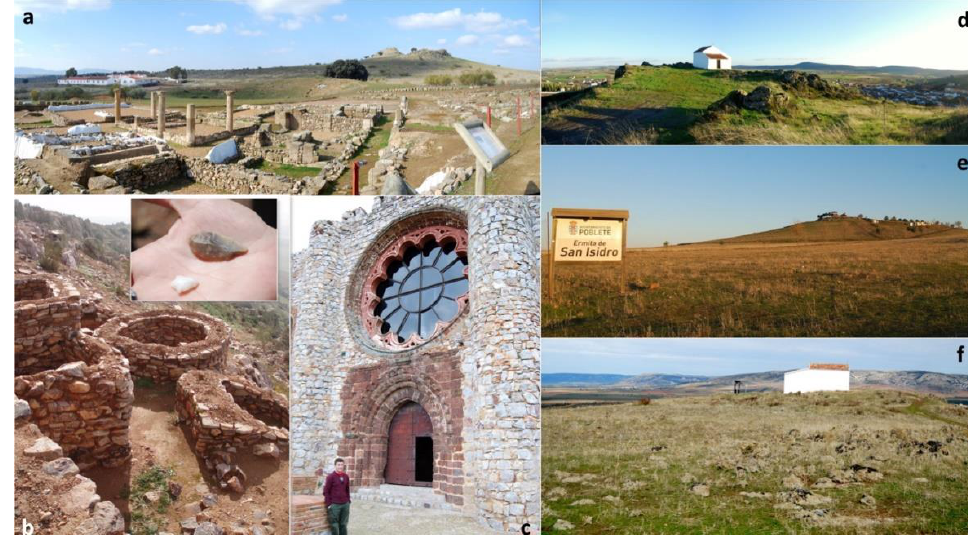
Figure 13. ( a ) Archaeological Roman site of Sisapo on the Los Castillejos volcano natural monument (La Bienvenida, Almodóvar del Campo); ( b ) archaeological Bronze Age site of La Encantada and detail of arrowheads found in the nearest volcanic complex of Cerro Gordo-Varondillo; ( c ) doorway of the Calatrava La Nueva castle made of volcanic rocks (Aldea del Rey); ( d ) Santa Cruz hermitage (Alcolea de Calatrava); ( e ) San Isidro hermitage (Poblete); ( f ) Jesús Nazareno hermitage (Porzuna). Geosciences 2020 , 10 , x FOR PEER REVIEW